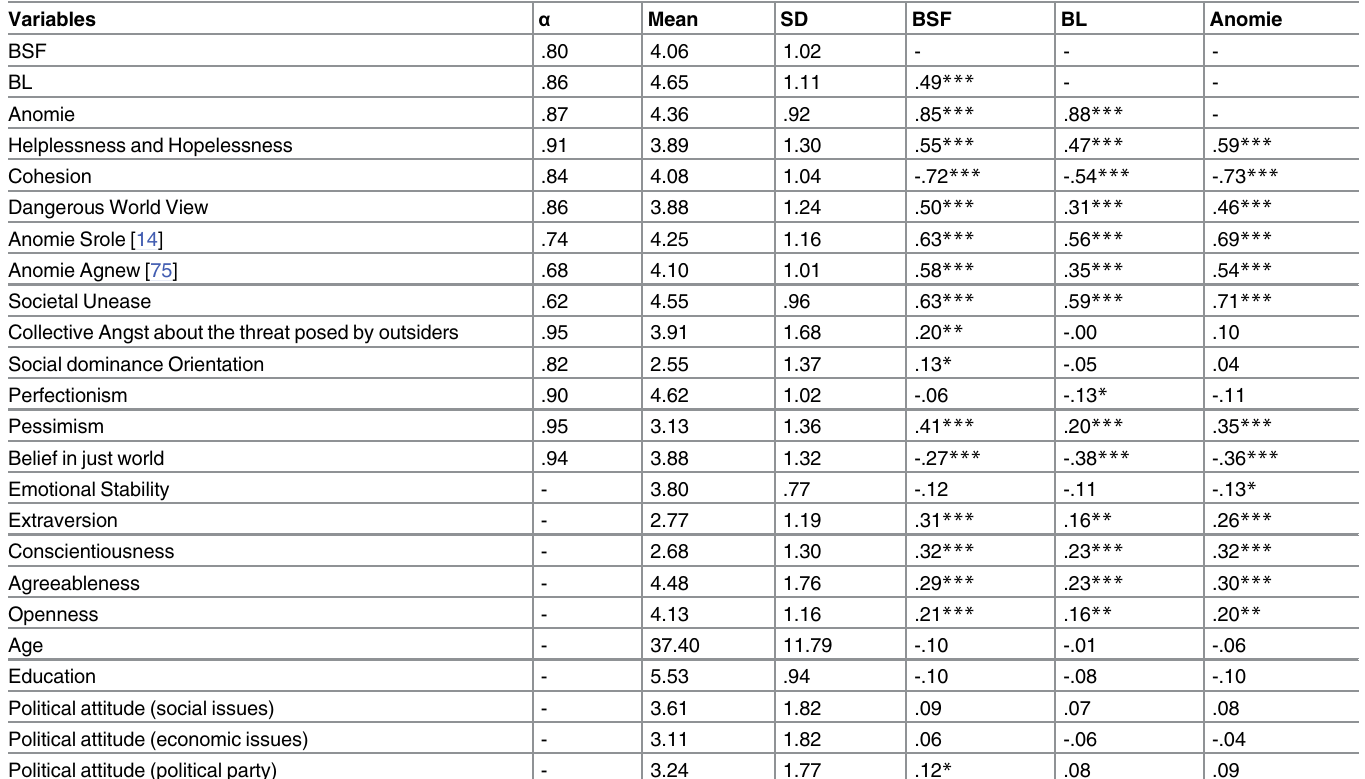
Table 3. Descriptives and bivariate correlations (Study